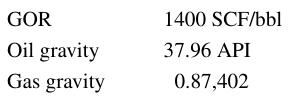
Table 6 Properties of stock tank